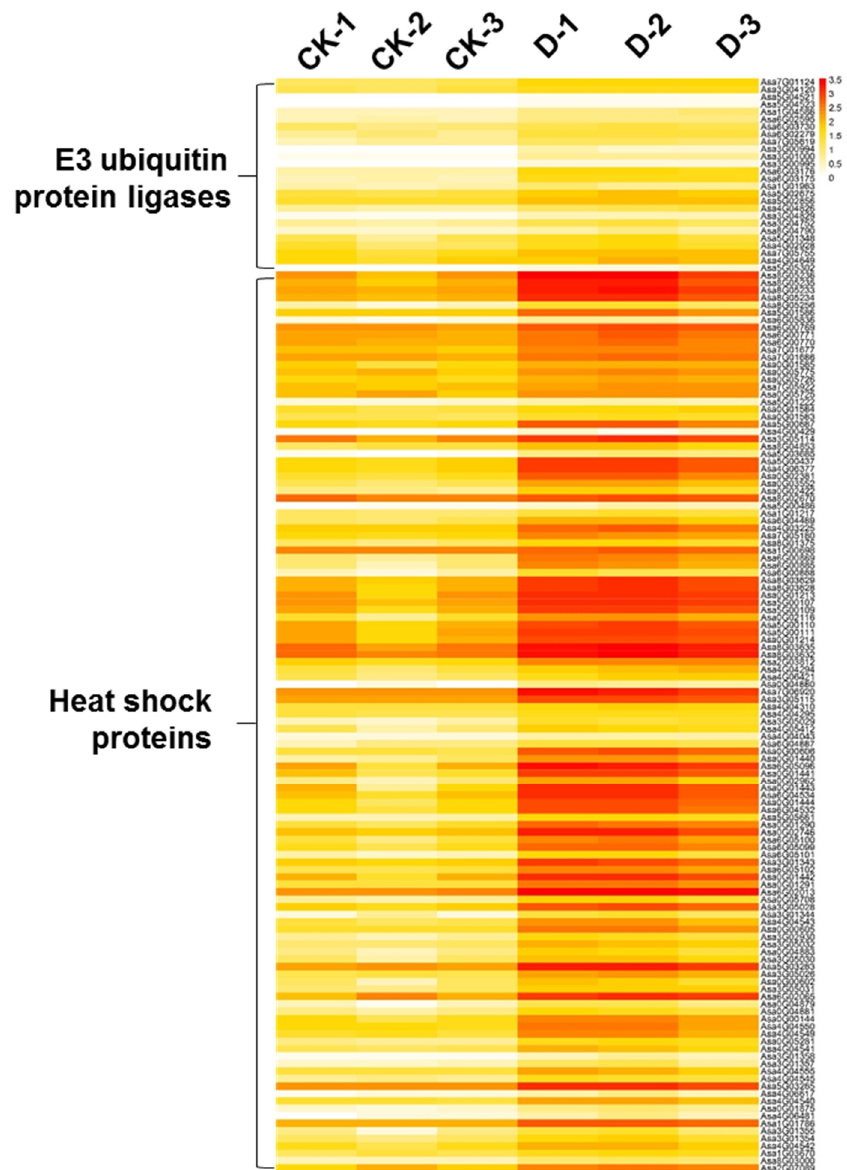
Figure 7. The heatmap shows the upregulation of E3 ubiquitin ligases and heat shock proteins in drought-treated garlic leaves. The color scale indicates log2 of normalized reads. CK, garlic plants grown under normal conditions; D, garlic plants grown under drought stress.